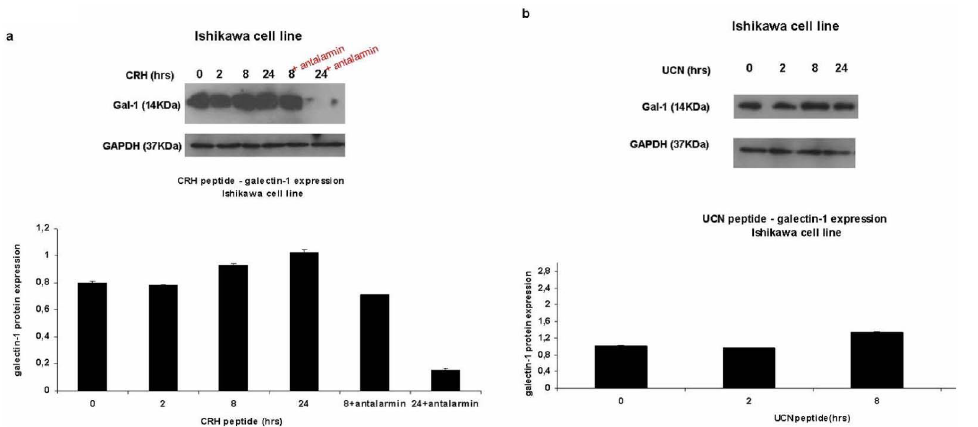
Figure 2. Galectin-1 is upregulated in Ishikawa cell line upon CRH and UCN stimulation and this is mediated through CRHR1. Western blot immunodetection of galectin-1 (14 kDa) protein expression in Ishikawa cell line, regulated by CRH and UCN neuropeptides. GAPDH (37 KDa) was used as a house keeping gene. 2a: In Ishikawa cell line, galectin-1 expression is upregulated by CRH, showing a higher expression at 8 hrs and 24 hrs of stimulation. When antalarmin is added, galectin-1 shows an impaired expression mostly at 24 hrs of stimulation. 2b: In Ishikawa cell line, galectin-1 is upregulated by UCN, showing a higher expression at 8 hrs of stimulation.